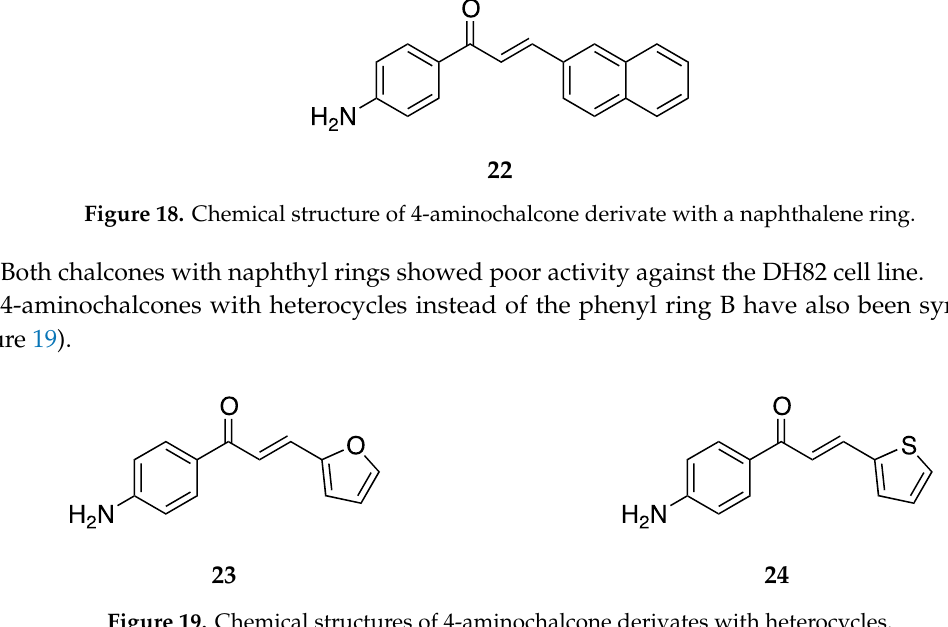
Figure 19. Chemical structures of 4-aminochalcone derivates with heterocycles.